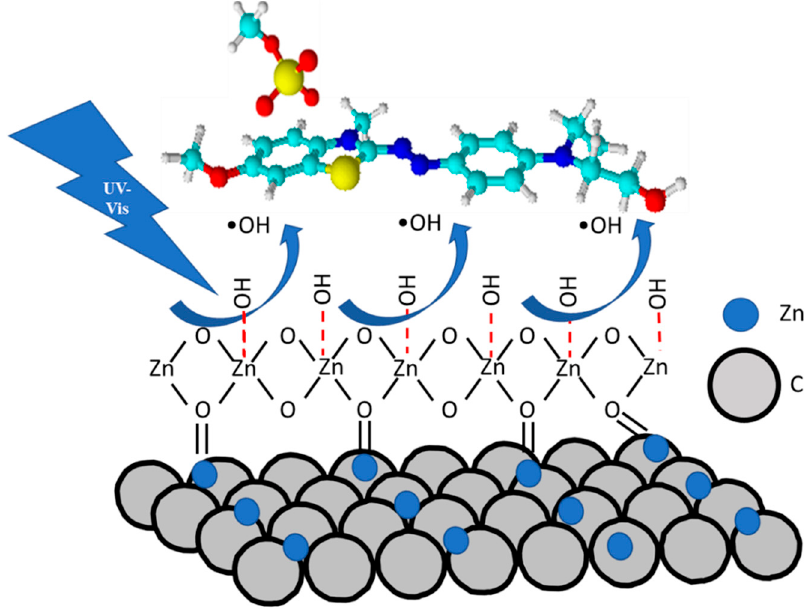
Figure 7. Mechanism for the photocatalytic degradation of the BB41 on C / Zn and C / ZnO / Zn composites.